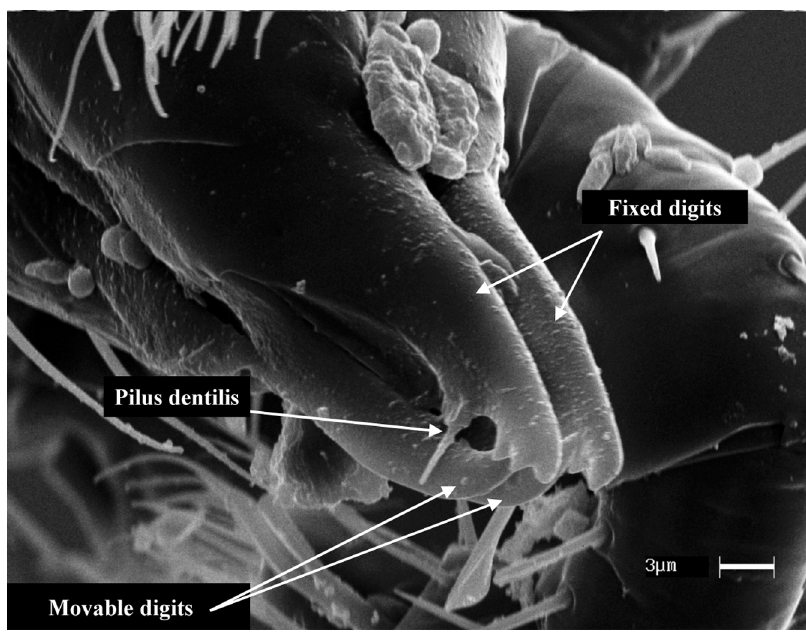
Fig. 4. Chelicerae of the phy- toseiid mite Typhlodromus rhenanoides (Athias-Henri-